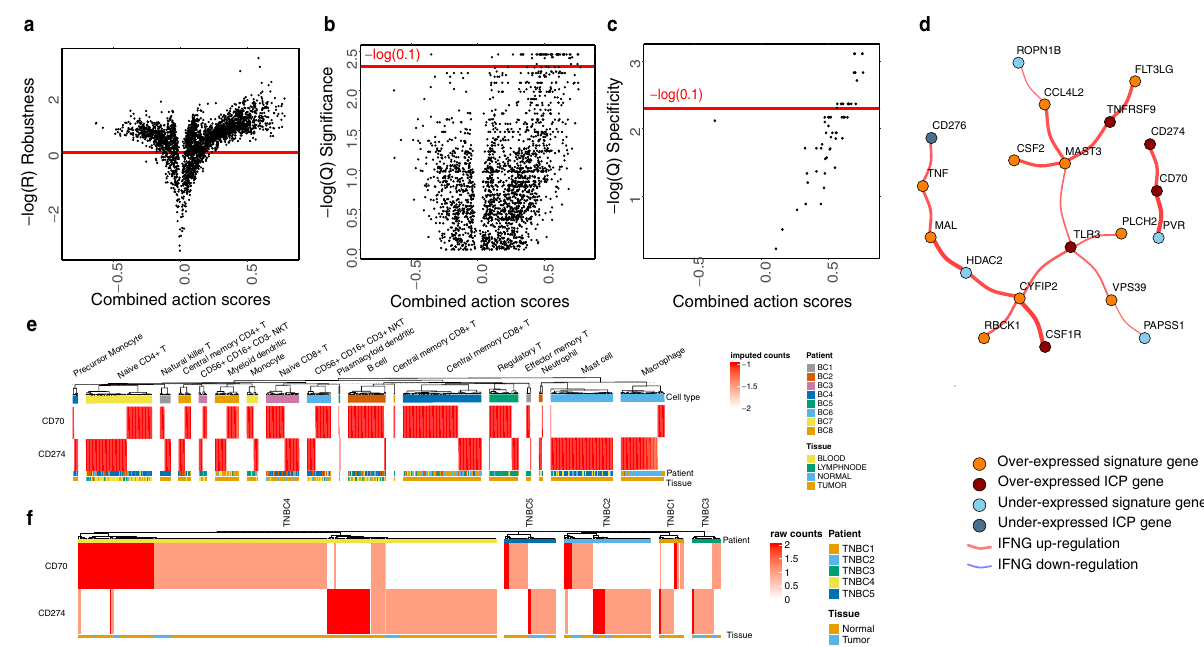
Fig. 3 Interactions of T-cell dysfunction signature genes with immune checkpoints in breast cancer. ImogiMap-based assessment of combinatorial interactions for T-cell dysfunction signature genes in basal-like breast cancer (based on RNA expression data from tumors of 172 patients), and therapeutically actionable ICPs, based on their associations with the IFNG expression. a Combined action score robustness metric. A normalized root mean square deviation (RMSD) is calculated for each combined action score through random sampling (1000x) of sub-cohorts with 70% coverage of the complete cohort. Scores with high robustness, (cid:1) log R ð Þ > 0 (red horizontal line) are selected for further analysis (see “ Methods ” ). b The signi fi cance metric for the combined action score. An FDR (Benjamini-Hochberg (BH) method) corrected Q -value based on the Wilcoxon signed-rank test is calculated for robust scores. Scores with Q Significance < 0 : 1 are selected for further analysis. c A BH-corrected Q -value for speci fi city is calculated for each robust and signi fi cant interaction. Scores with Q Specificity < 0 : 1 are selected for further analysis. d The graphical network representing robust, signi fi cant, and speci fi c combinatorial associations with IFN γ levels. Red (blue) edges represent upregulation (downregulation) of IFNG gene expression level. Dark red (dark blue) vertices identify overexpression (low-expression) of ICP genes and orange (blue) vertices identify overexpression (low-expression) of T-cell dysfunction signature genes. The single cell mRNA expression patterns of CD70 and CD274 in ( e ) breast cancer-associated immune cells 11 and ( f ) tumors from fi ve patients with triple-negative breast cancer patients 34